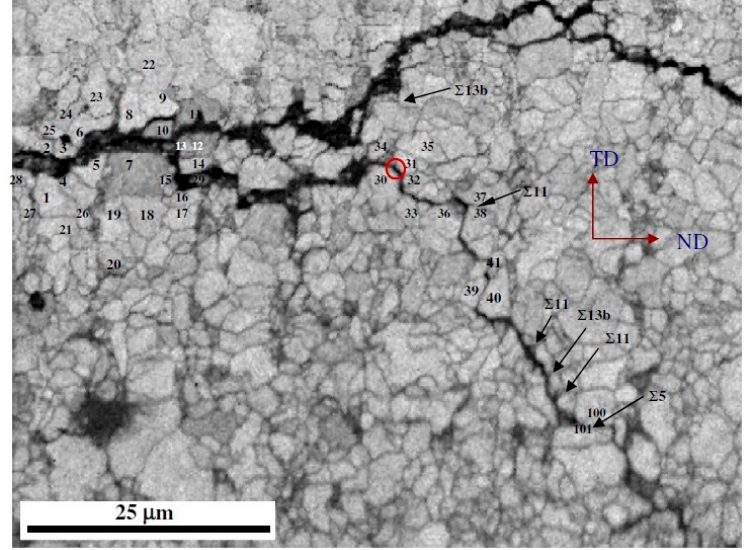
Figure 11. Electron backscatter diffraction (EBSD) map of the SCC crack propagation in X65 pipeline steel [12]. Reproduced with permission from [12], Elsevier, 2009.